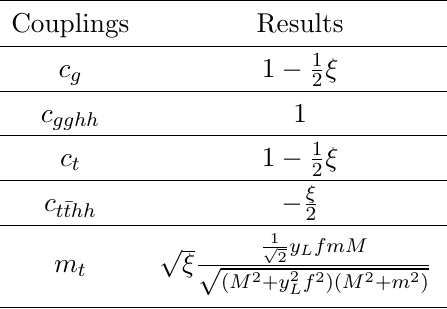
Table 10 . Higgs Couplings and top mass in CMNNM. MCHM of 5 + 1 representation and CTHM of 8 + 1 representation are very similar to this